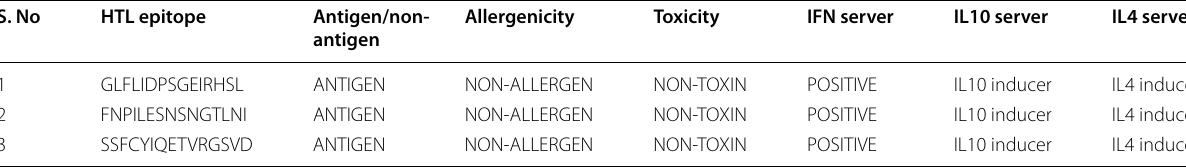
Table 2 Results of the finally shortlisted cytokine-inducing HTL epitopes S.